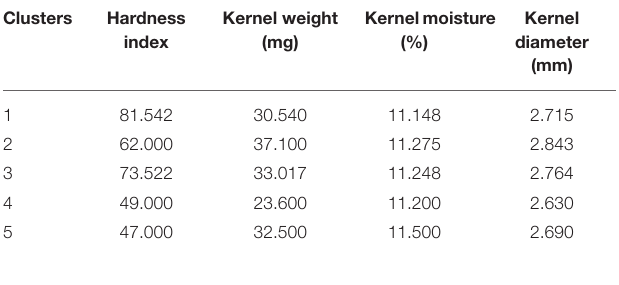
TABLE 4 | Mean values of different quality traits regarding single kernel characteristics of wheat genotypes in cluster analysis. Clusters